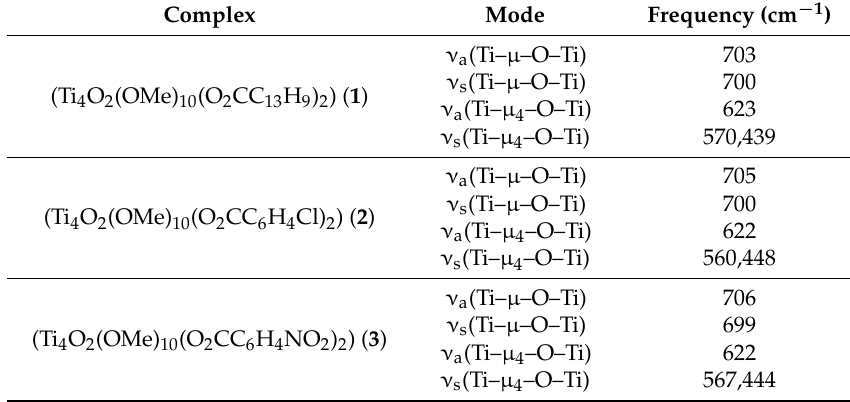
Table 4. The calculated frequencies of the (Ti–O–Ti) modes of {Ti 2 -( µ 2 -O)} and {Ti 4 -( µ 4 -O)}